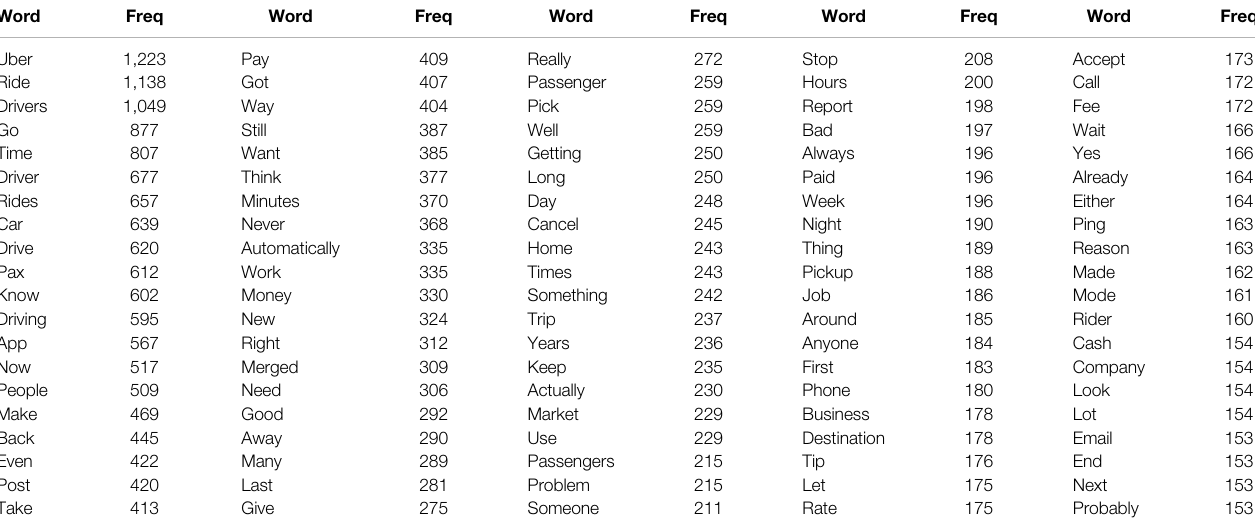
TABLE 2 | Most frequent 100 words of Lyft